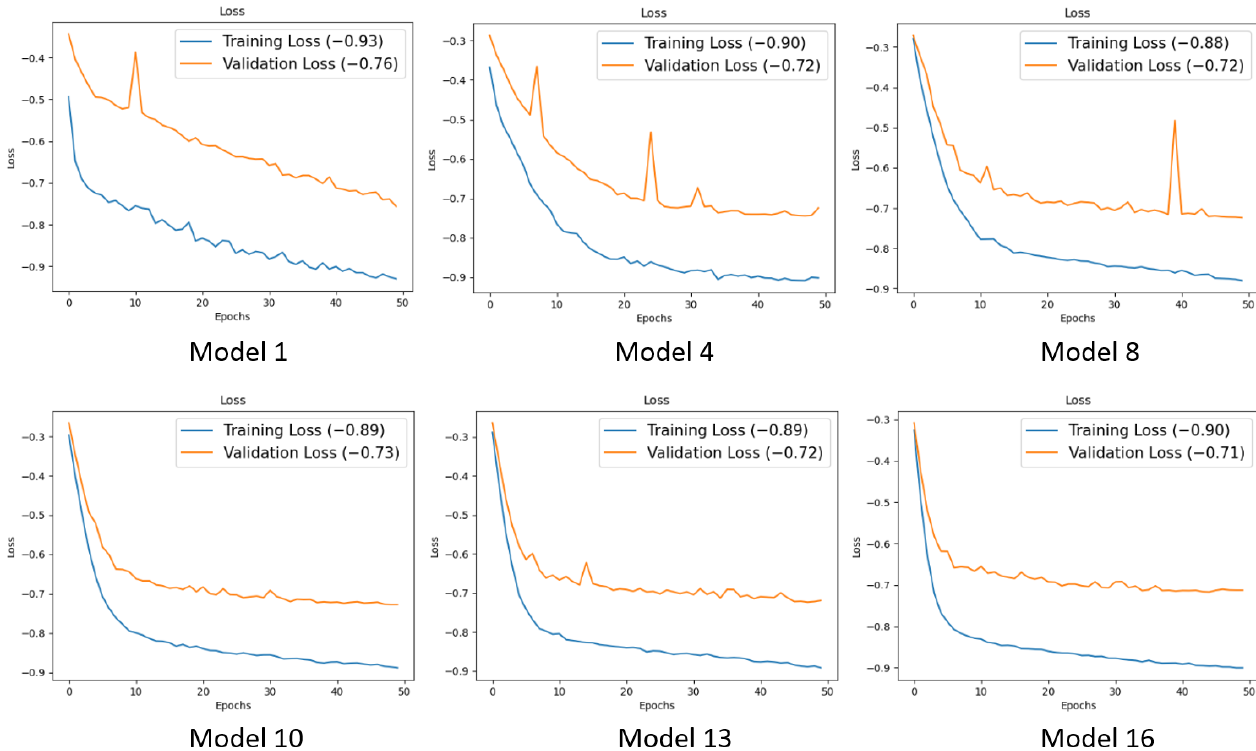
Figure 6. Training and validation loss for six models using increasing training data. Models 1, 4, 8, 10, 13, and 16 use 1, 4, 8, 10, 13, and 16 12-digit hydrologic unit (HU12) watersheds for training, with 1000 samples used for each watershed. Stable training accuracies with Dice coefficients ranging from 0.88 to 0.90 are achieved for models with seven or more training watersheds (Figure 7). Dice values range from 0.70 to 0.74 for validation samples for models with seven or more training watersheds. Dice scores appear slightly more stable for models with 13 to 16 training watersheds, when training scores range from 0.89 to 0.90 and validation scores range from 0.71 to 0.72. While using a similar U-net model to predict hydrographic streams from lidar data, [33] reports 13 percent difference between training and validation samples, achieving Dice values of 0.97 and 0.84 for training and validation,